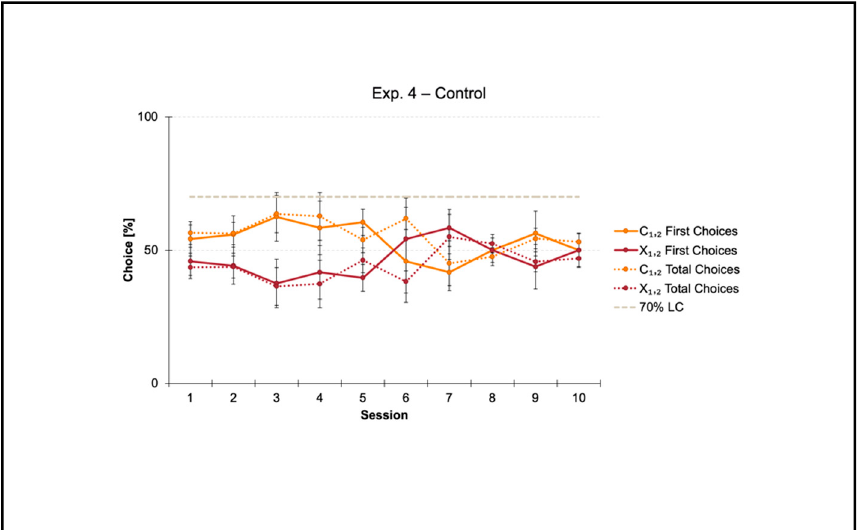
Figure 6. Results of Experiment 4. The line chart shows the percentages of choice (mean, SEM) obtained by fish towards the two diagonals (C 1,2 versus X 1,2 ) over time, that is, for each of the 10 training sessions. Solid lines represent first choices, and dotted lines represent total choices, while the gray dashed line represents the 70% learning criterion (LC).